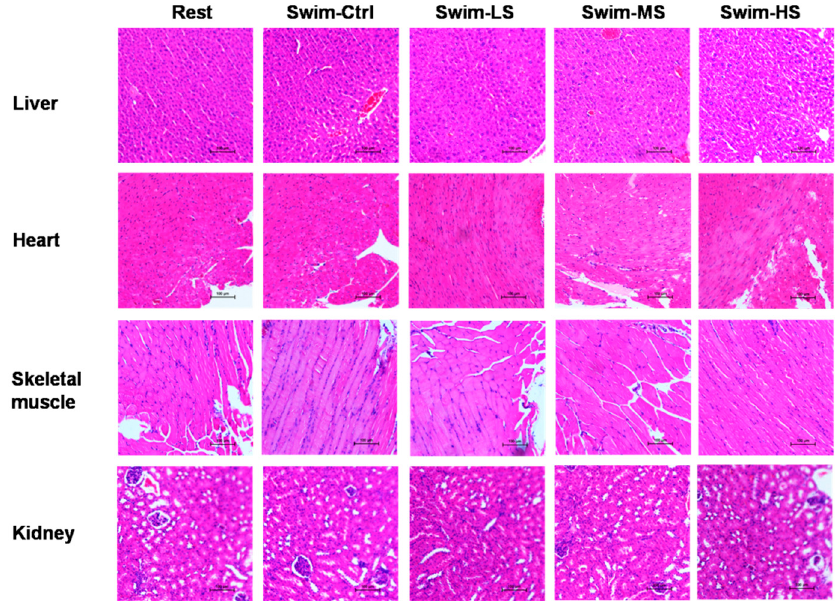
Figure 2. The effects of Salecan on the histopathology of liver, heart, skeletal muscle, and kidney of mice in different groups. Thick sections of 5 μ m were stained with hematoxylin-eosin staining (H & E) (magnification, ×200).